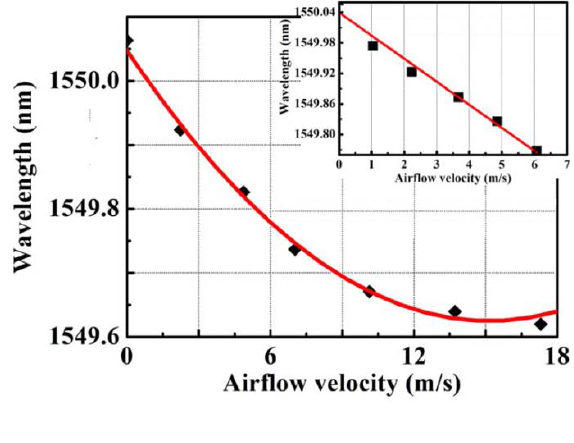
Figure 6. Resonant wavelength versus applied airflow velocity of the anemometer using silver-coated fiber Bragg grating [60].